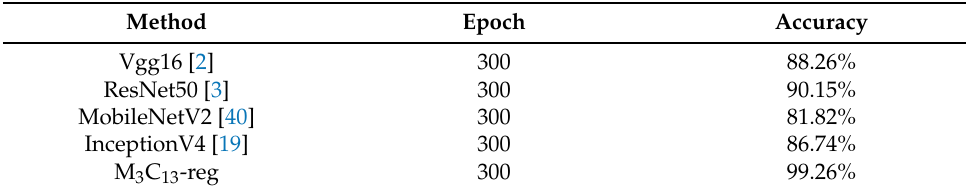
Figure 6. The Accuracy of Each Model. Table 6. Accuracy of the other Three Models when Training 300